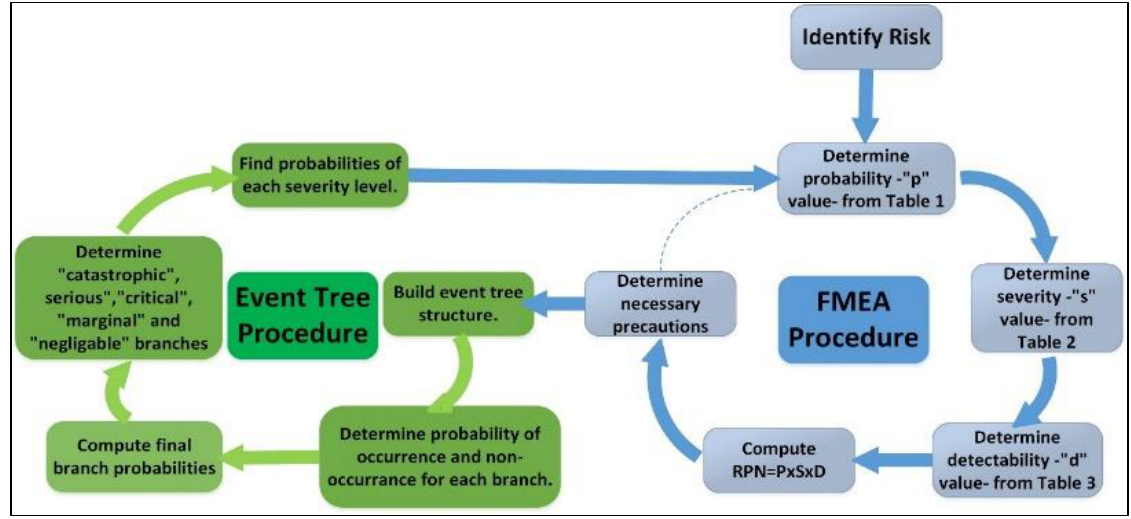
Figure 3: FMEA and ETA are integrated together for further analysis of risk severity degrees and probabilities. Source: Authors, (2022).